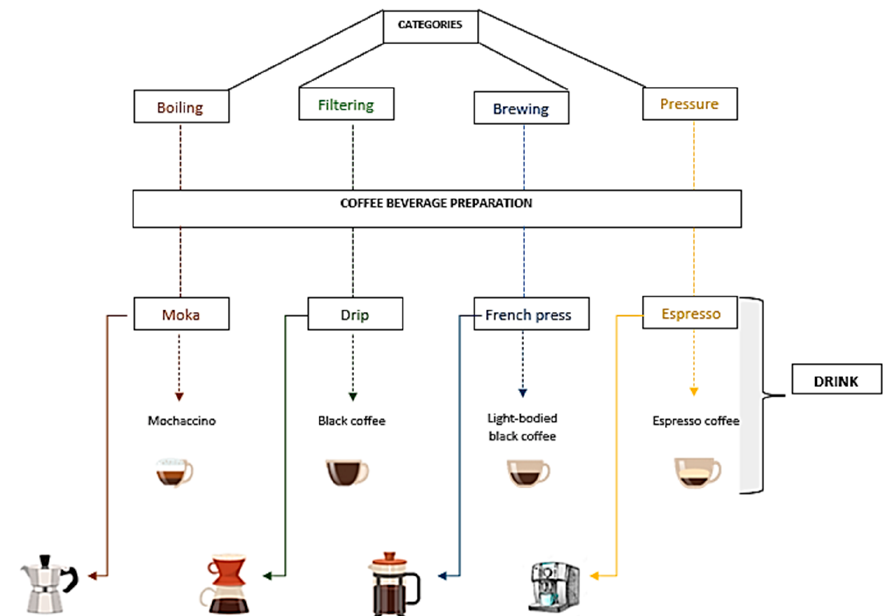
Figure 4. Preparation of co ff ee beverages